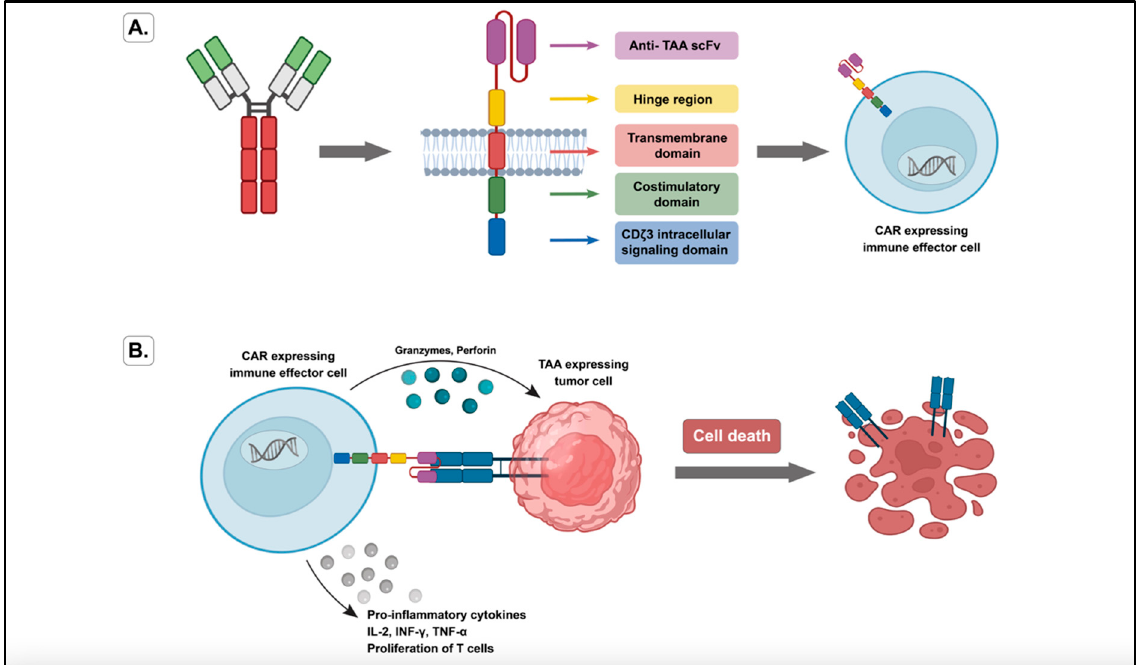
Figure 2. ( A ) Schematic illustration showing the variable light and heavy chains that are sequenced and combined into a single-chain variable fragment (scFv) to convert monoclonal antibody (mAb) to chimeric antigen receptor (CAR). ( B ) Schematic illustration showing the binding between the CAR-expressing immune effector cell and its tumor-associated antigen (TAA)-expressing tumor cell. This binding results in the production of cytotoxic granules and cytokines, which in turn causes stimulation of the host immune system and tumor cell death.